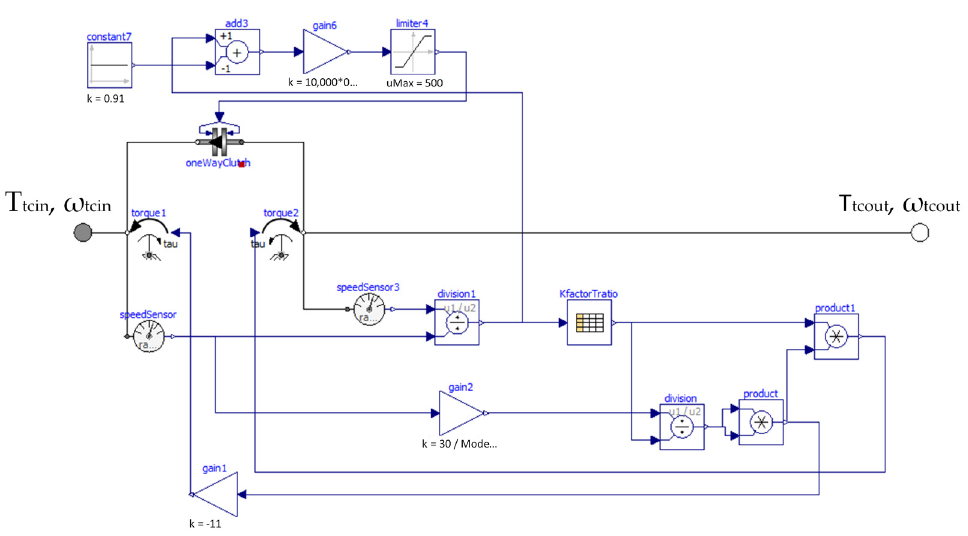
Figure 5. Diagram of the “torque converter” module in the developed test simulation.